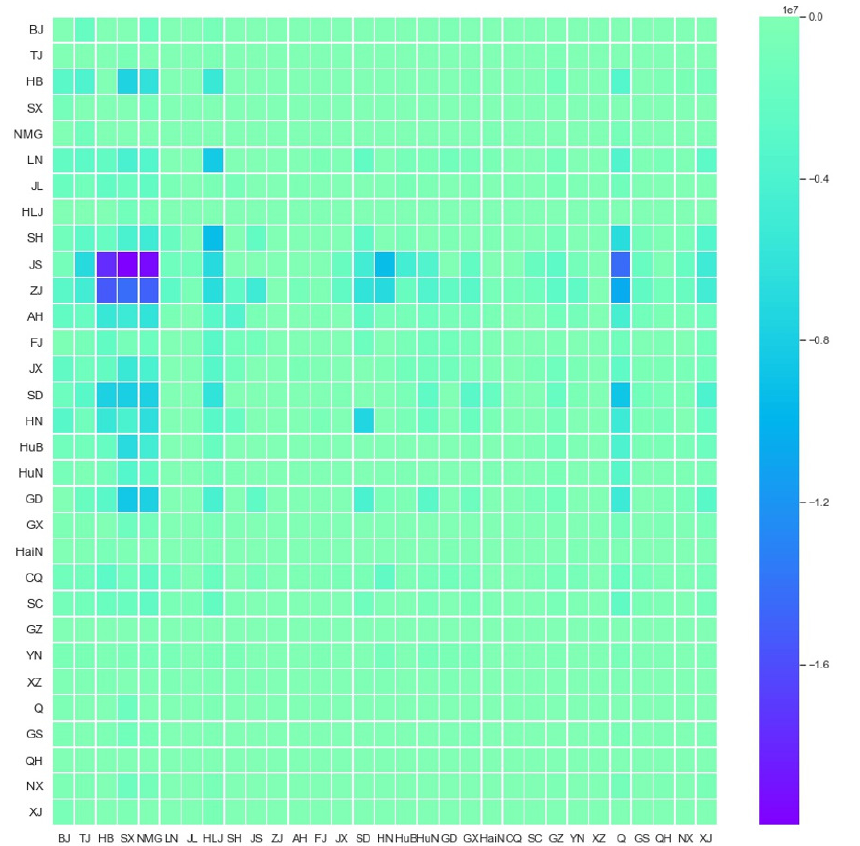
Figure 4. China’s inter-provincial economic benefits (CNY) net movement